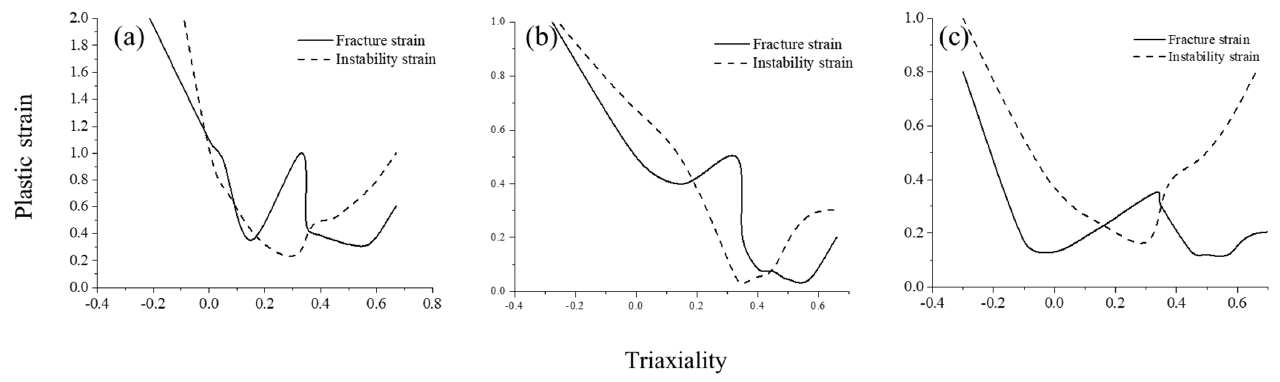
Figure 15. Optimized failure and instability loci using GISSMO for tetrahedral-based models: ( a ) MAT 1, ( b ) MAT 2, and ( c ) MAT 3.